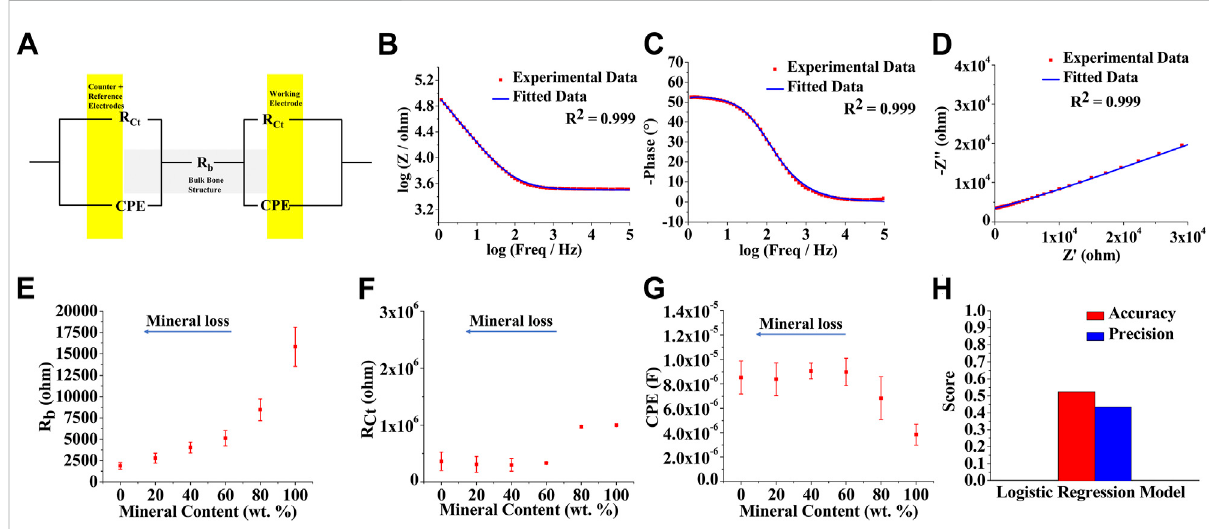
FIGURE 3 Equivalent circuit modeling for the factor deconvolution of electrochemical impedance spectroscopy (EIS) data (A) Equivalent circuit model used for fi tting the bone EIS spectra. R b = resistance from bulk bone structure, R Ct = bone surface-metal electrode interfacial charge-transfer resistance, CPE = non-ideal double-layer capacitance (constant phase element) at the bone surface-metal electrode interface or contact region. Representative fi tting results (20%) shown as (B) Bode magnitude (C) Bode phase angle, and (D) Nyquist plots. Equivalent circuit model- parametriccharacterizationofbonesamplesatdifferentlevelsofdemineralization.Plotsshowingvariation of (E) R b (F) R Ct ,and (G) CPEasafunction of bone mineral content (H) Classi fi cation performance of a logistic regression discrimination model using impedance data and fi tted equivalent circuitelement data for training [ n (total) =70; n (0 wt%) = 12, n (20 wt%) =12, n (40 wt%) = 12, n (60 wt%) = 12, n (80 wt%) =9, n (100 wt%) =13] and testing [ n (total) = 21; n (0 wt%) = 4, n (20 wt%) = 4, n (40 wt%) = 4, n (60 wt%) = 3, n (80 wt%) = 3, n (100 wt%) = 3] datasets.